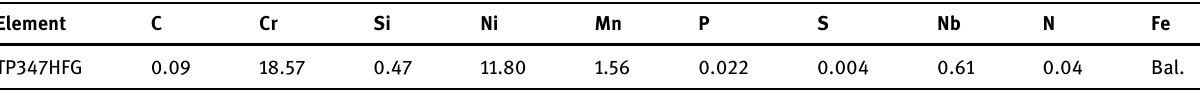
Table 1: The chemical composition of TP347HFG steel ( wt% )